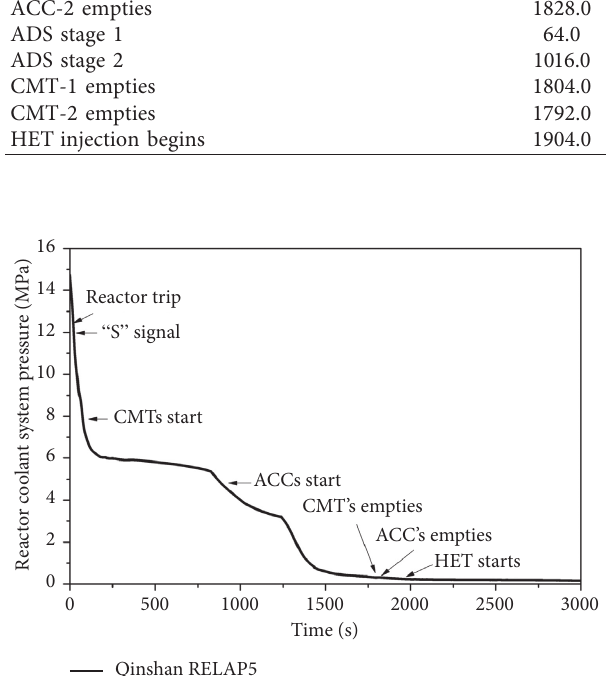
Figure 13: 2-inch CL break RCS pressure transient.